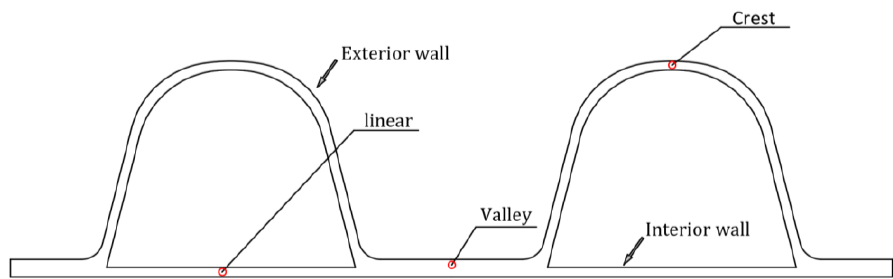
Figure 7. Detection section of pipes.